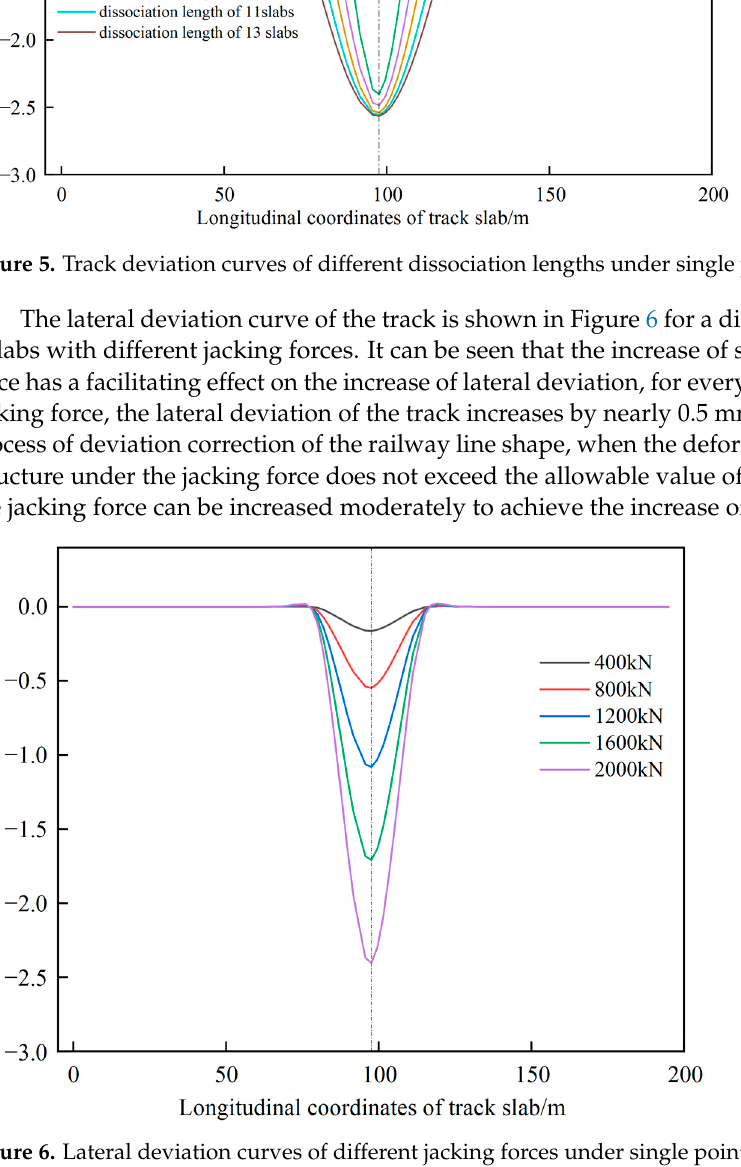
Figure 6. Lateral deviation curves of different jacking forces under single point jacking.